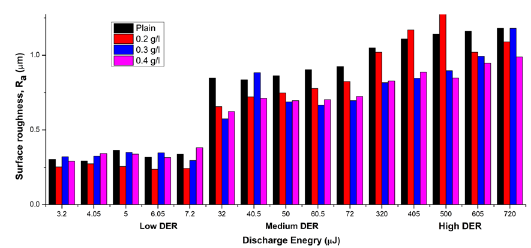
Figure 5. Surface roughness Vs SiC and Energy Level.